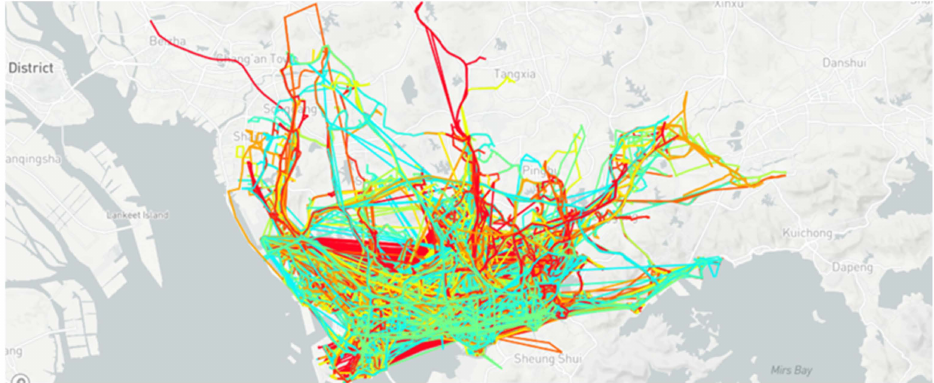
Figure 4. Driving track of electric